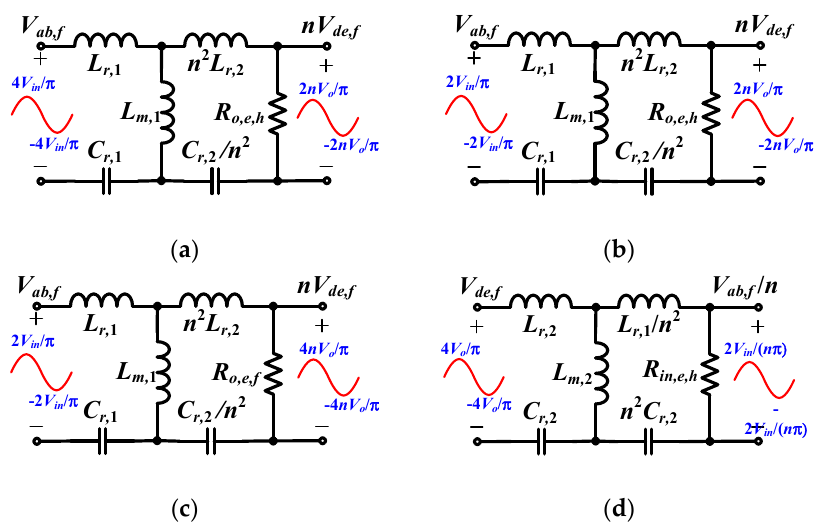
Figure 5. Resonant circuits using fundamental frequency analysis: ( a ) low voltage range input with forward power flow; ( b ) medium voltage range input with forward power flow; ( c ) high voltage range input with forward power flow; ( d ) backward power flow operation.